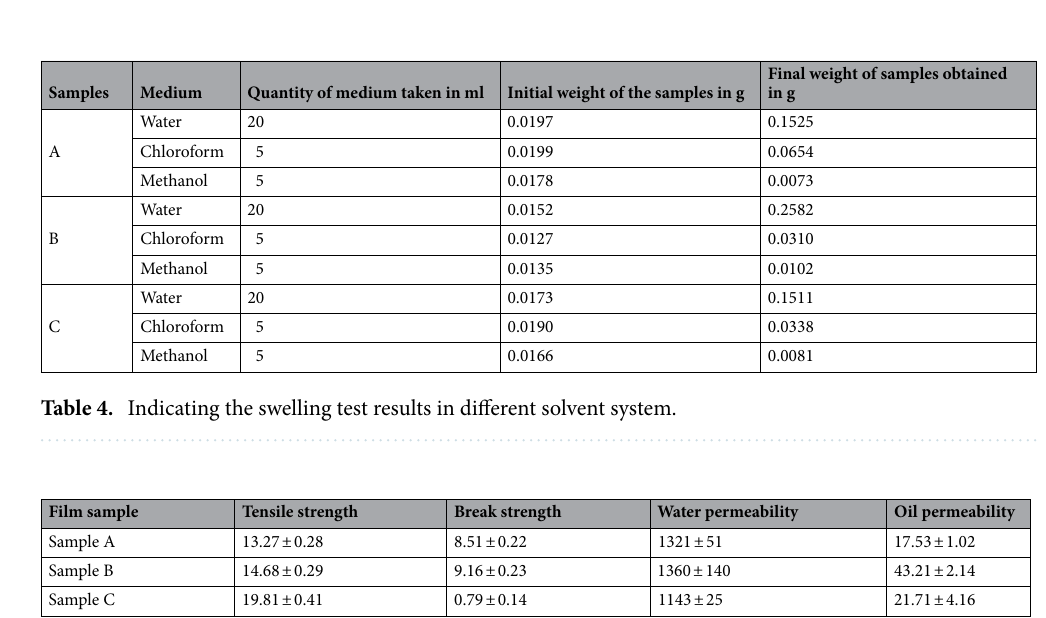
Table 5. Few important characteristic features possessed by the developed film for the ideal packaging